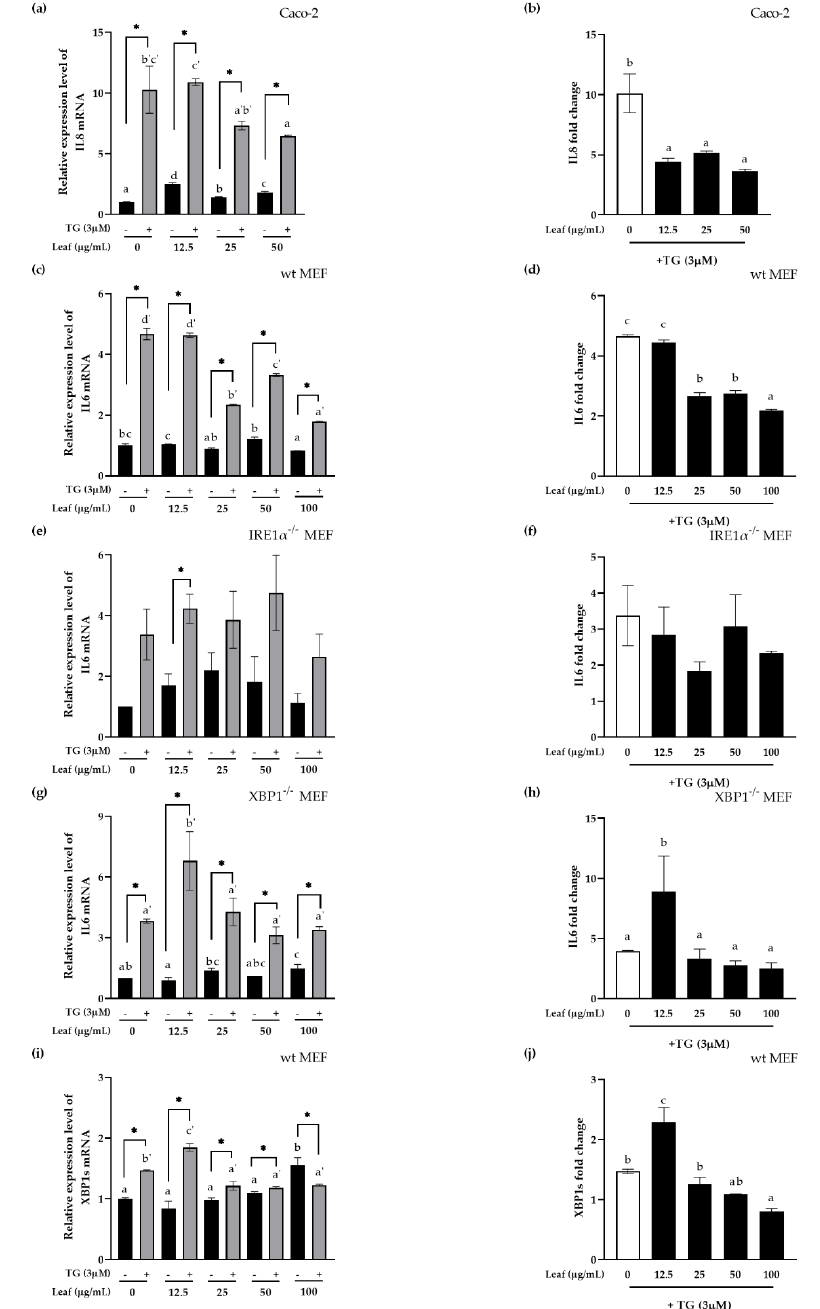
Figure 4. Anti-inflammatory effects of LL on the pro-inflammatory response induced by ER stress in XBP1 dependent manner. Polarized Caco-2 cells ( a , b ), wt MEF cells ( c , d ), IRE1 α KO MEF ( e , f ), XBP1 KO MEF ( g , h ) were pretreated apically with the indicated LL concentrations for 24 h followed by 3 µ M TG stimulation apically for an additional 4 h ( a – h ). Wt MEF cells ( i , j ) were pretreated apically with the indicated LL concentrations for 24 h followed by 3 µ M TG stimulation apically for an additional 1 h. The cDNA from the cells were prepared for real-time qPCR targeting the genes as indicated and normalized by human GAPDH for Caco-2 or mouse β -actin for MEF. The fold change in target genes expression by TG was calculated at each LL concentration ( b , d , f , h , j ). The white bar represents negative control. Data are shown as the means ± SD of at least three independent experiments. Significant differences between different concentrations were analyzed using Duncan’s multiple range test with one-way ANOVA and values labeled with different letters are significantly different ( p < 0.05). Significant different value compared to the control group was analyzed using a student’s t -test. * p < 0.05. LL: Lycium barbarum leaf, TG: